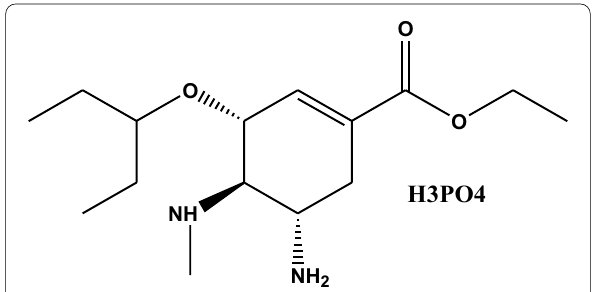
Fig. 1 Chemical structure of Oseltamivir phosphate